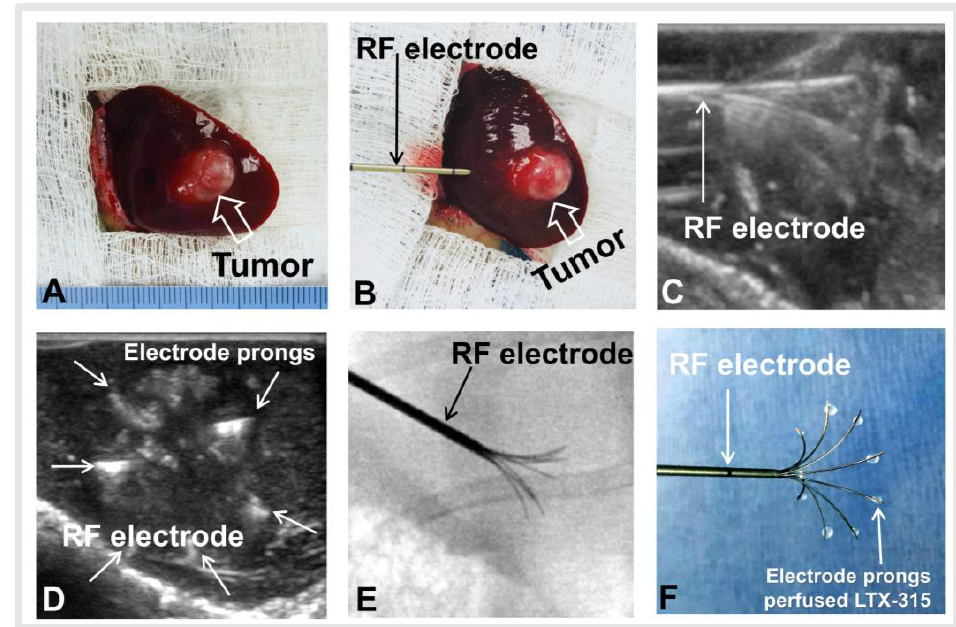
Figure 4. Creation of rabbit orthotopic hepatic VX2 tumor for incomplete radiofrequency ablation (RFA) and LTX-315 treatment. ( A ) An orthotopic hepatic VX2 tumor (arrow) was created in the left lobe liver of the rabbit. ( B – E ) Under real-time ultrasound imaging and X-ray imaging guidance, the ablation electrode was placed into the tumor and the multiple prongs were opened to not fully cover the tumor periphery to create an incomplete RFA tumor model. ( F ) The multimodal RFA electrode permitted simultaneous peritumoral infusion of LTX-315 to the residual tumors in the ablated tumor margin during RFA treatment.